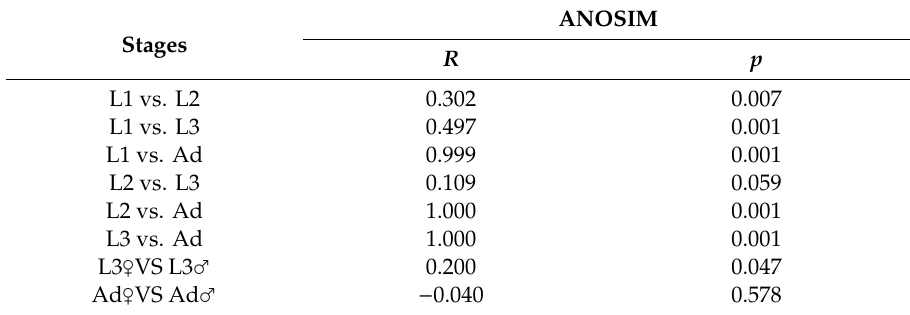
Figure 3. LEfSe analysis of intestinal bacterial biomarkers associated with host types. Identified phylotype biomarkers ranked by e ff ect size, and the alpha value was < 0.05. Cladogram representing the taxonomic hierarchical structure of the phylotype biomarkers identified among four host types, red, phylotypes overrepresented in gut of L1; green, phylotypes statistically overrepresented in gut of L2; blue, phylotypes statistically overrepresented in gut of L3; purple, phylotypes statistically overrepresented in gut of Ad. L1, 1st instar; L2, 2nd instar; L3, 3rd instar; Ad, Adults. Table 1. Di ff erences in bacteria community composition depending on di ff erent development stages and sexes by analyses of similarities